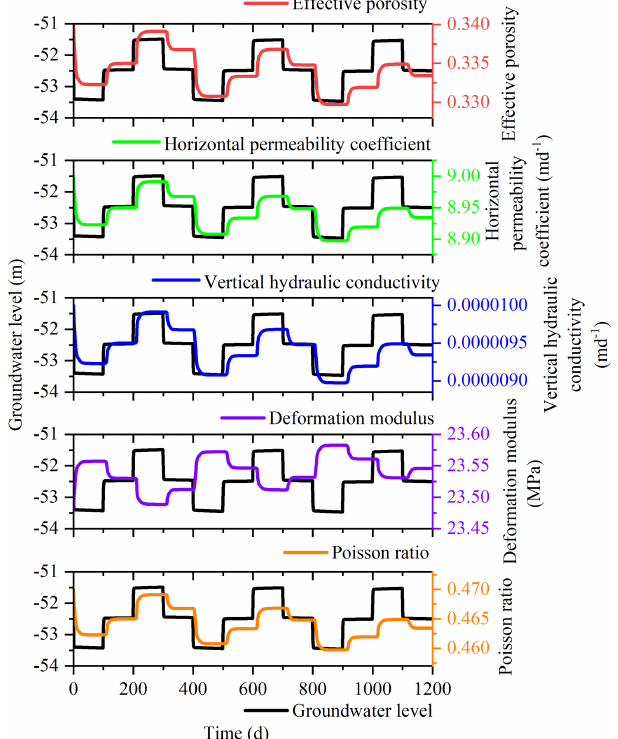
Figure 9. Parameter and water level with stress period in the fourth confined aquifer group under the second pumping and recharge